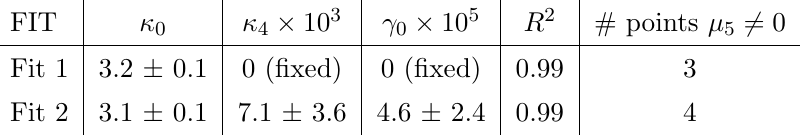
Table 2 . Numerical values of the parameters corresponding to the (cid:12)ts in (cid:12)gure 5. The last column indicates the number of lower (cid:22) 5 points